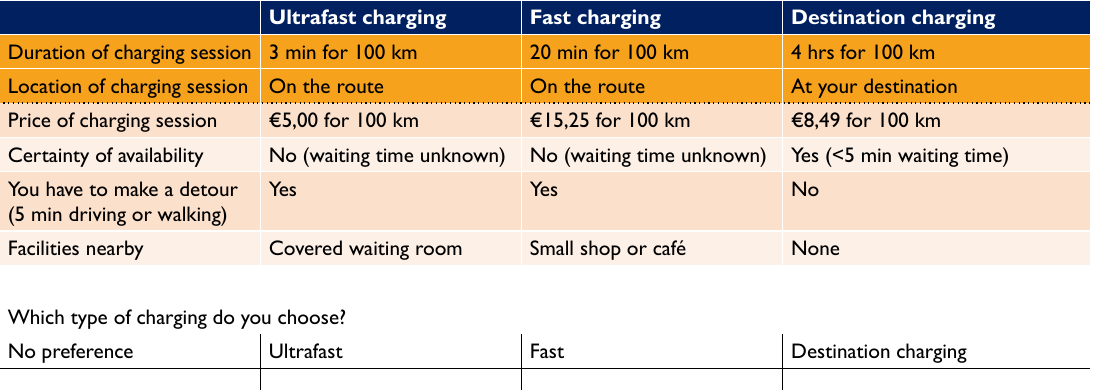
Figure 1. Example of a choice set as used in the stated choice experiment. The input for “You will charge [...] kilometres of range” was taken from the previous question on the respondent’s most recent charging